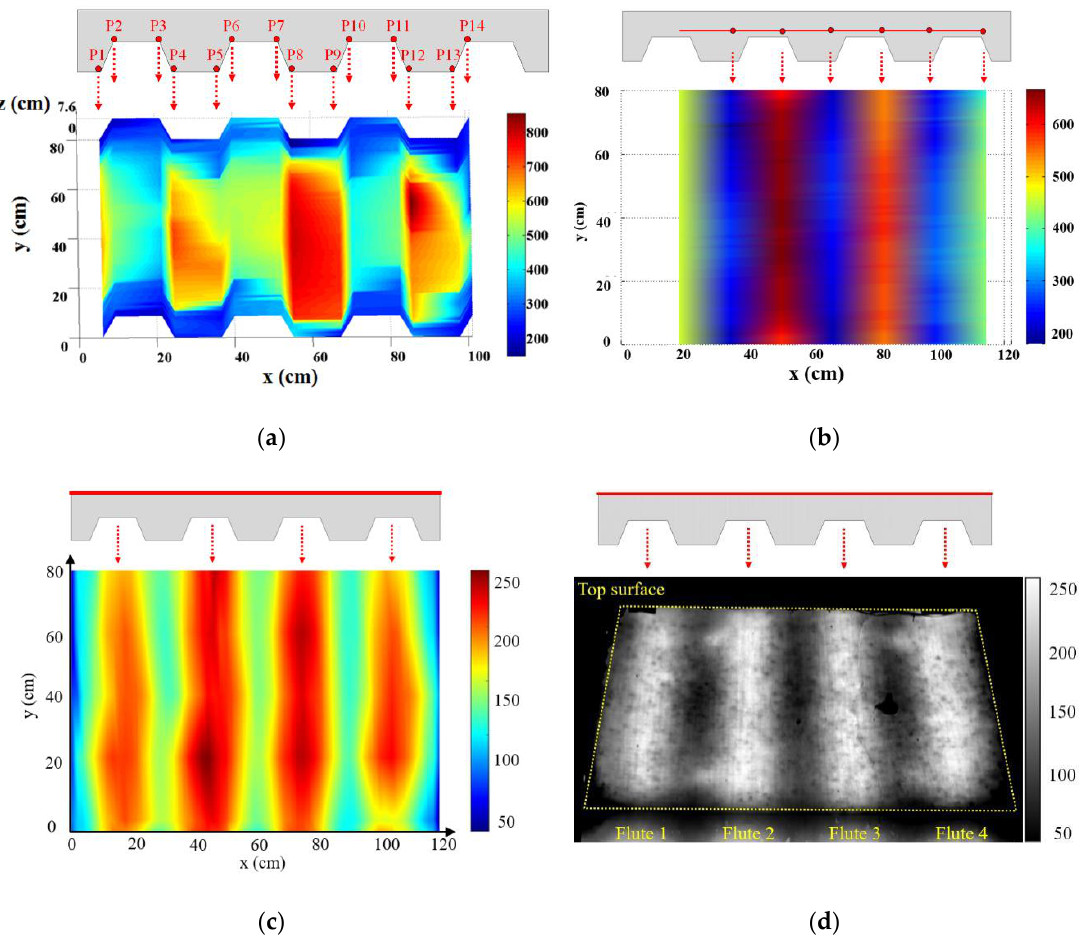
Figure 9. Visualization of temperature measured from: ( a ) DFOS-1 in CS-1 at 25 min, ( b ) DFOS-2 in CS-1 at 50 min, ( c ) DFOS-4 in CS-5 at 150 min, and ( d ) infrared camera for CS-3 at 180 min. The legends show temperature in °C. The red lines and dots represent various distributed sensors, respectively.